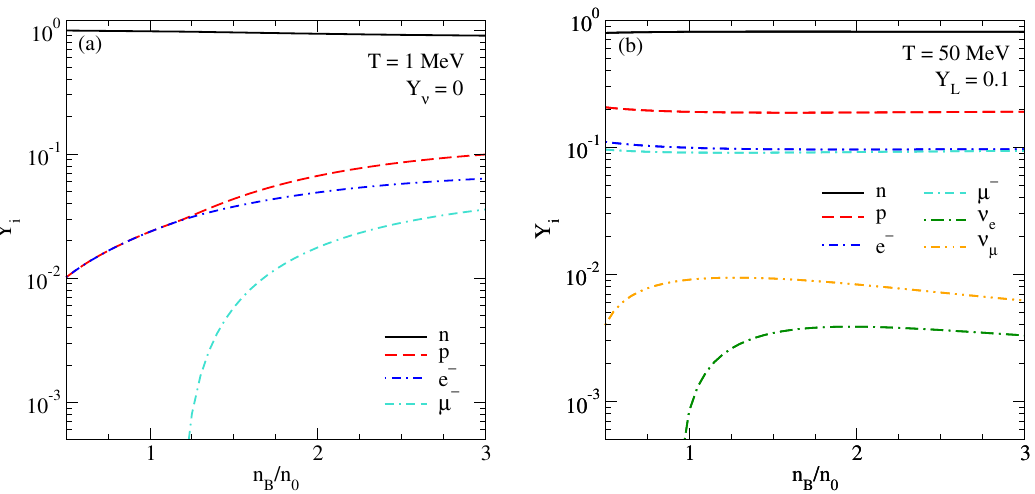
Figure 1. Particle fractions as functions of the baryon density for ( a ) neutrino-transparent matter ( Y ν = 0) at T = 1MeV; ( b ) neutrino-trapped matter at Y L = 0.1 and T =